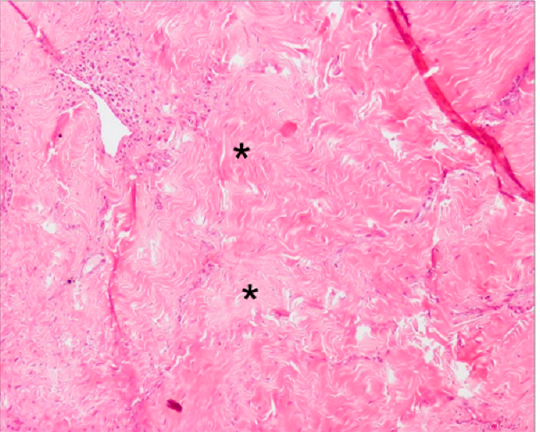
Figure 5. Light microscopy of 4 µm sections showing the substantial sclerotization of the deep collagen fibers, at a magnification of 10×. * = sclerotic areas.